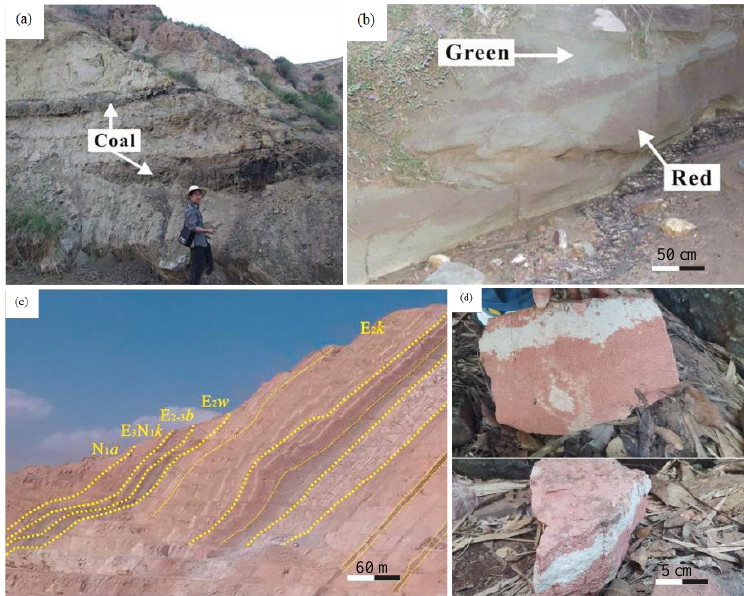
Figure 4. ( a ) Coal measures within the green facies; ( b ) green facies and relicts of red facies in outcrop showing bleaching of red sandstone to green; ( c ) gray sandstones and conglomerates separated by red mudstone interbeds; ( d ) reduction strips in the red bed are distributed along the bedding plane. ( a , b ) are reprinted with permission from Ref. [15]. 2019, Elsevier; ( c ) is reprinted with permission from Ref. [91]. 2019, Elsevier; ( d ) is from Danxia Mountain, Guangdong, China.